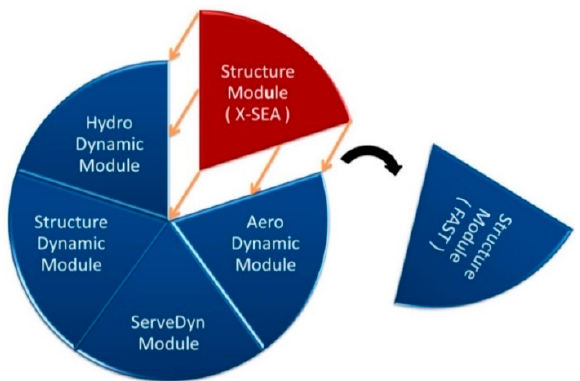
Figure 4. Basic layout of structure module within X-SEA.